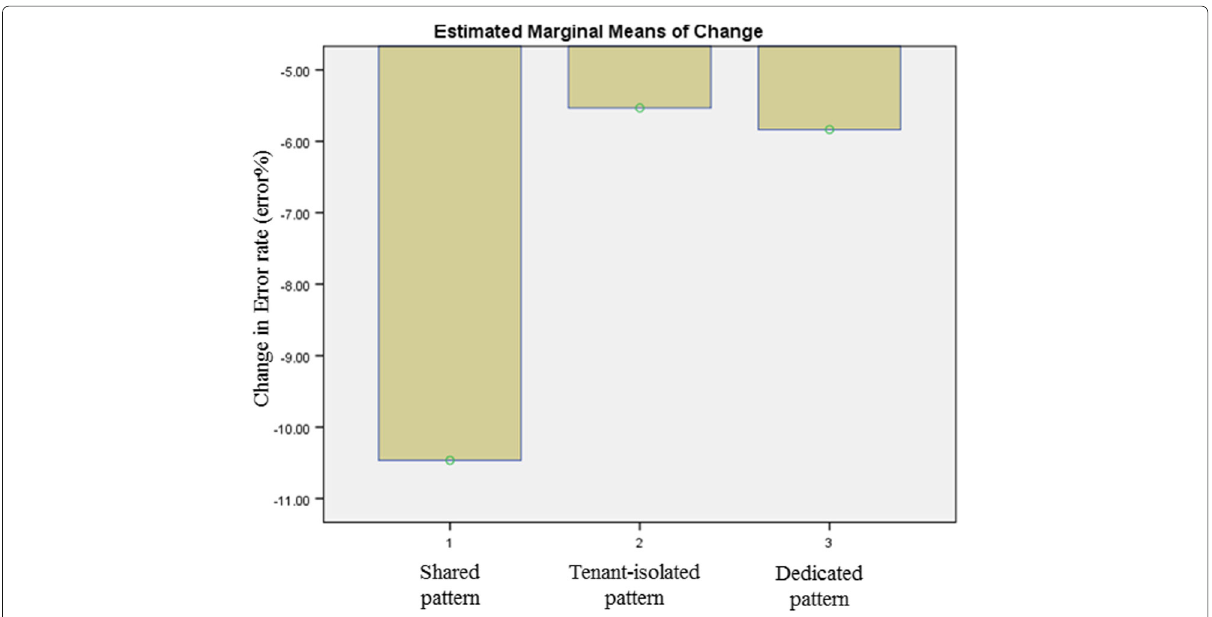
Fig. 23 Changes in Error% [CS3]